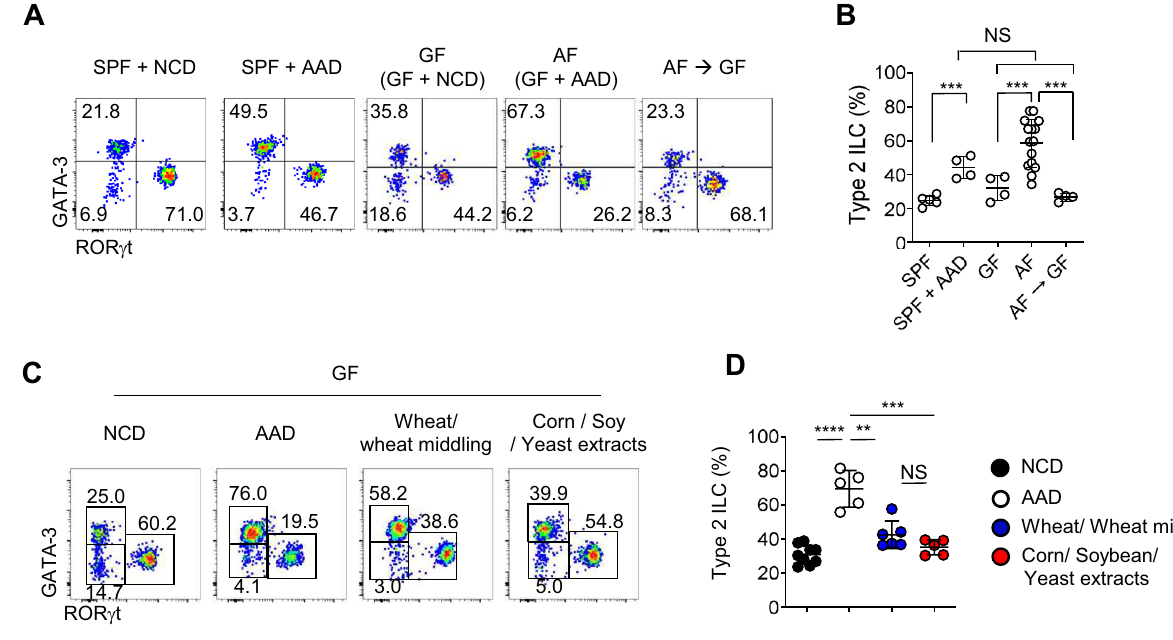
Figure 2. Dietary proteins restore the ILC2 phenotype of AF mice. Single-cell suspensions of the siLP mononuclear cells isolated from mice fed with the indicated diets were analyzed by flow cytometry. ( A and B ) SPF or GF mice were fed with the indicated diets. Dietary shift from AAD to NCD in GF mice (AF GF) was at the 6th week and mice were analyzed at the 9 th week after birth. Dot plots show ILCs after gating Lin − CD45 + Thy1.2 + cells (A), and graph shows statistical analysis of frequencies of type 2 ILCs in indicated mice (N = 3~14) (B). ( C and D ) GF mice were fed with indicated diet. Dot plots show representative dot plots of ILCs after gating Lin − CD45 + Thy1.2 + cells (C) and graph shows statistical analysis (N=5~9) (D). Pooled results from two independent experiments are shown. Numbers indicate frequencies of cells in adjacent gates, and each dot represents an individual mouse. Horizontal bars indicate mean values, and error bars show SD. * p <0.05, ** p <0.01, *** p <0.001, **** p <0.0001. NS, not significant (unpaired two-tailed student t -test). siLP, small intestinal lamina propria; ILC, innate lymphoid cell; SPF, specific pathogen-free; GF, germ-free; AF, antigen-free; NCD, normal chow diet; AAD, amino-acid